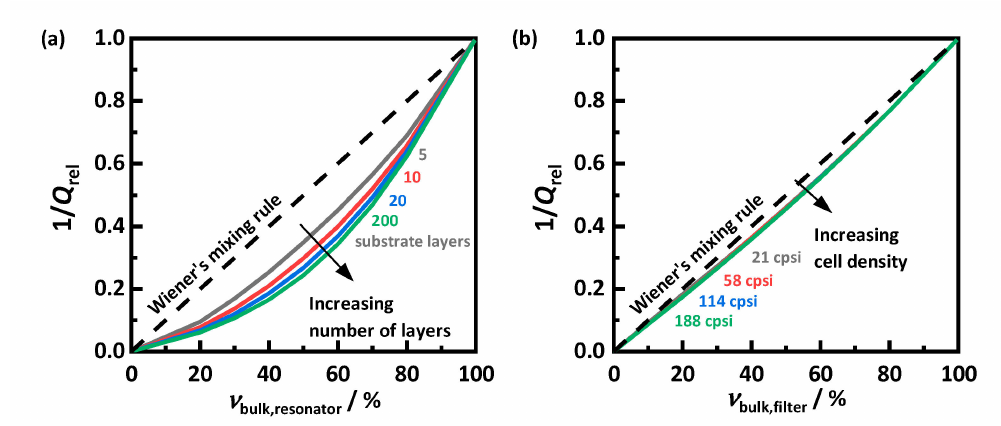
Figure 5. Inverse quality factor Q − 1 depending on the bulk fraction ν bulk at a substrate conductivity σ bulk of 100 mS/m for ( a ) different numbers of substrate layers in the resonator setup, respectively, and ( b ) different cell densities in the filter setup according to Table 1 and as indicated by the color-coded labels within the figure. Dashed line: Wiener’s mixing rule for a series circuit ( k = 1) in Equation (5).